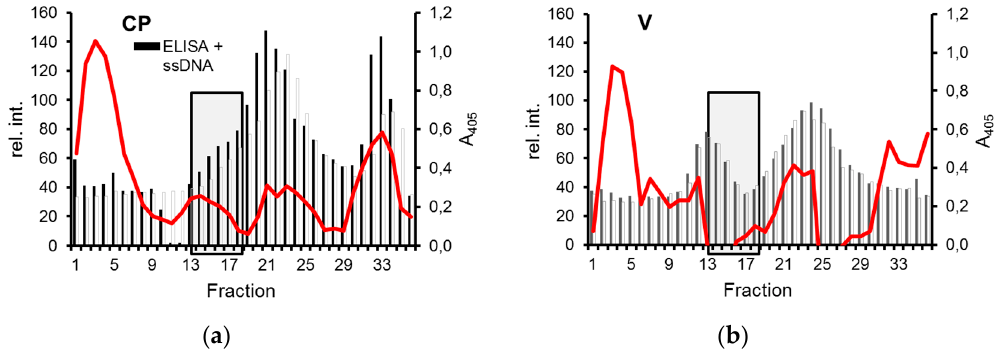
Figure 5. Separation of CP and ssDNA by density gradient centrifugation. Extract pellets either from CP ‐ expressing ( a ) or control cells ( b ) were incubated with ((+)ssDNA) or without (( − )ssDNA) pBlue:CR250 ssDNA, and analyzed in Cs 2 SO 4 gradients by ELISA for CP as described in Figure 2 and by dot blot hybridization for DNA. Relative hybridization signal intensities (rel. int., red lines) are shown after background subtraction on the left y axis, ELISA values on the right axis. Fractions with relevant differences are boxed.